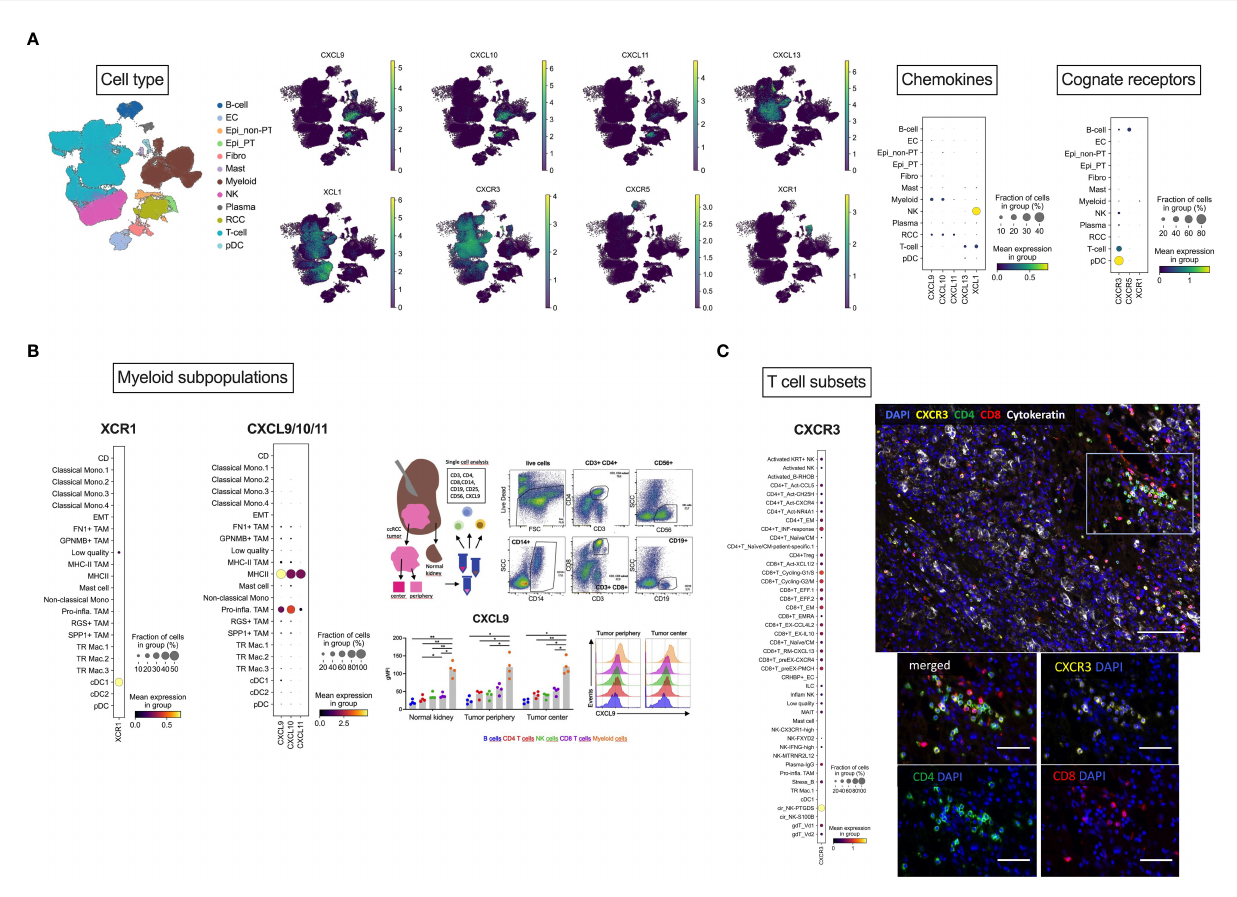
FIGURE 3 Cellular localization of CXCL9/10/11, CXCL13, XCL1 and their cognate receptors by scRNAseq analysis. (A) Overview of cellular localization of chemokines (CXCL9/10/11, CXCL13 and XCL1) and the cognate receptors (CXCR3, CXCR5 and XCR1). (B) Dotplot expression analysis of annotated myeloid subpopulations in the dataset (49) with targets CXCL9/10 and XCR1 demonstrating dendritic cells as the major source of XCR1 and M1 TAMs for CXCL9/10. As a representative member of the chemokine cluster, CXCL9 was further analyzed by fl ow cytometry. RCC tumors from tumor center and tumor periphery and matched normal adjacent kidney tissues were resected and freshly processed to obtain a single-cell suspension. Cells were analyzed using fl ow-cytometry. Dotplots of a representative gating of live cells are shown: CD3 + CD4 + and CD3 + CD8 + T cells, CD56 + NK cells, CD19 + B cells and CD14 + myeloid cells. Levels of CXCL9 were assessed in the speci fi c immune cell subpopulations. FACS identi fi ed CD14 + tumor-in fi ltrating myeloid cells as the population with the highest levels of CXCL9 protein. (C) Dotplot expression analysis of annotated T cell subsets in the dataset with the target CXCR3 showing CD4 + and CD8 + T cells as the major source of CXCR3. This fi nding was also con fi rmed by multiplex immuno fl uorescence analysis. Multiplex immuno fl uorescence image of RCC showing coexpression of CXCR3 with CD8 and CD4 T cells. Scale bar = 100 m m. (B) Magni fi cation of TILs region. Scale bar = 50 m m. Stastististical tests used: (A) two-way ANOVA with Geisser-Greenhouse correction with Tukey ’ s multiple comparisons test; * p <0.05, ** p